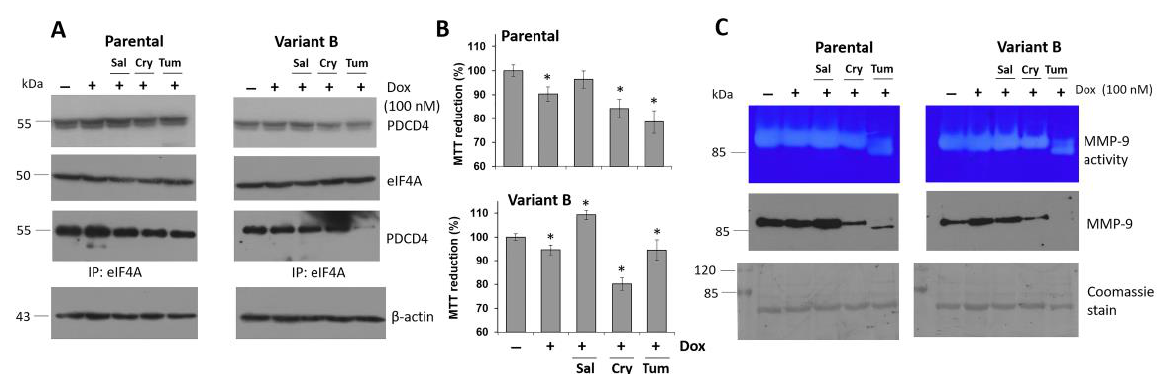
Figure 4. Chemoresistance is regulated by a terpene-derived molecule and ER-stress inducer com- pound. ( A ) Effect of concomitant Dox (100 nM) treatment with Salubrinal (Sal) (25 µ M), Cryptotan- shinone (Cry) (25 µ M), and Tunicamycin (Tum) (1 µ g/mL) on the expression of eIF4A, PDCD4, and characterization of protein interaction. ( B ) Employing the same conditions, cellular viability was evaluated in parental and variant B cells under the Dox treatment with Sal, Cry, and Tum. Mean values are presented (n = 6, mean ± SD), * p < 0.005 with respect to the control. ( C ) MMP-9 secretion was analyzed on supernatant medium using gelatin-substrate gels and the MMP-9 expression by WB. Membranes were processed by Coomassie stain as a loading